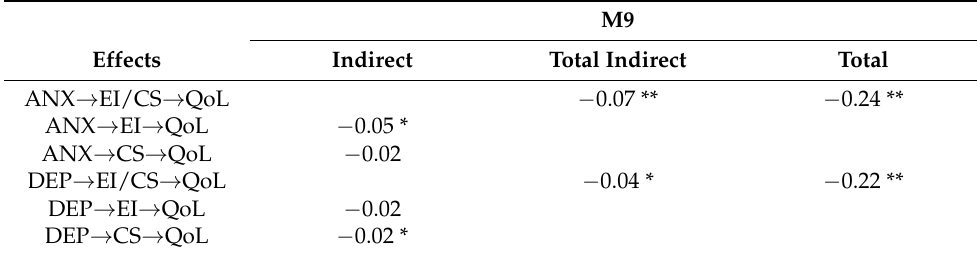
Table 3. Standardized indirect and total indirect effects of the mediation model.